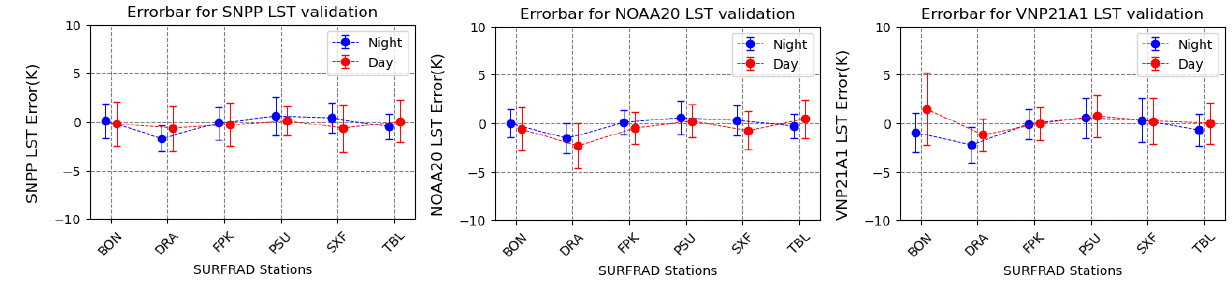
Figure 2. Site-wide validation results for SNPP ( left ) NOAA-20 ( middle ) and VNP21A1 ( right ). The top right plot shows the time series over the DRA site. It indicates a